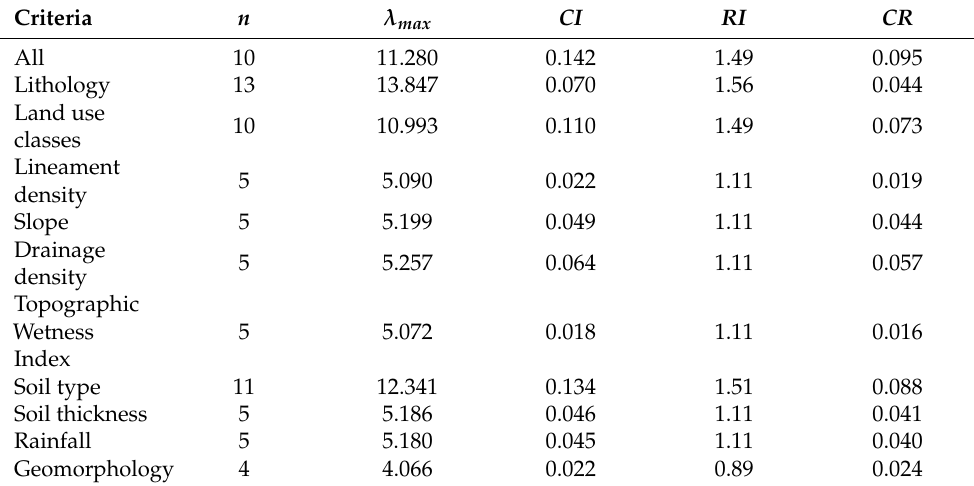
Table 6. The number of criteria and its sub-criteria ( n ), the largest eigenvalue of pairwise comparison judgment matrix ( λ max ), consistency index ( CI ), random consistency index ( RI ) and consistency ratio ( CR ) for the selected criteria to predict the GWPZs map in this